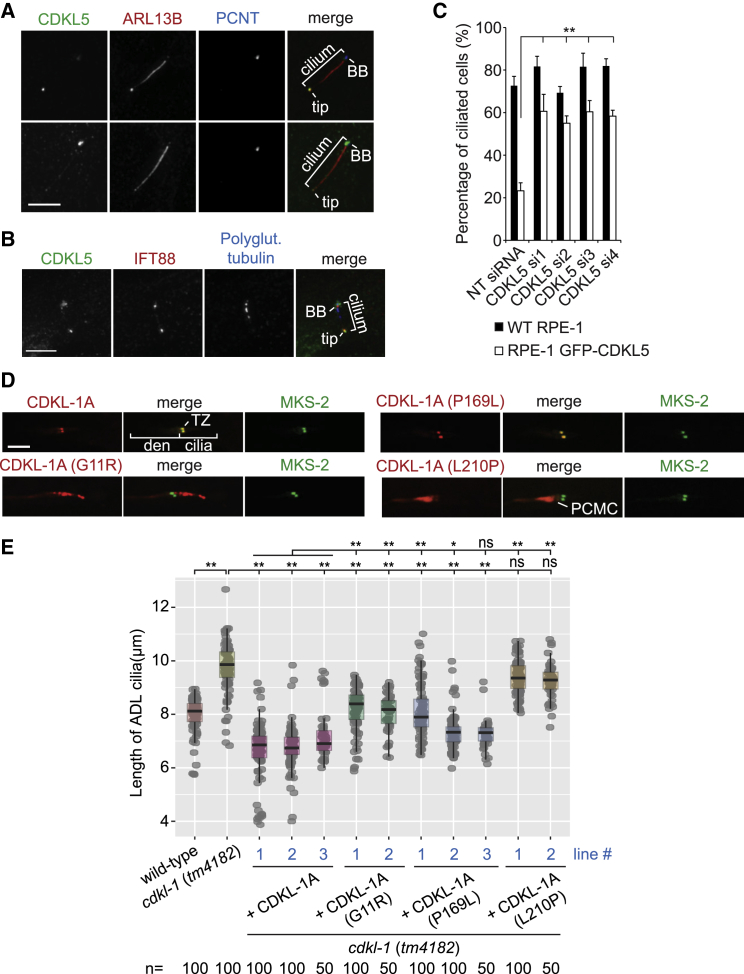
Human CDKL5 Localizes to Cilium and Affects Ciliogenesis When Overexpressed in RPE-1 Cells and Mutations Modeled in C. elegans CDKL-1 Disrupt Localization and/or Cilium Length Regulation(A) Immunofluorescence analysis of serum-starved hTERT RPE-1 cells expressing GFP-CDKL5 stained with antibodies against GFP, ARL13B (cilium marker), and PCNT (centrosome marker). The top and bottom panels are representative images showing different levels of GFP-CDKL5 localization to the BB and cilium tip. Scale bar, 5 μm.(B) Serum-starved hTERT RPE-1 GFP-CDKL5 cells were stained with antibodies against GFP, IFT88, and polyglutamylated tubulin (centriole/BB and axoneme marker). Scale bar, 5 μm.(C) Bar graph shows mean percentage of ciliated cells (n > 300 cells per sample, 3 independent experiments) in the serum-starved populations (72 hr) of hTERT RPE-1 and hTERT RPE-1 GFP-CDKL5 cells transfected with the indicated siRNAs. Error bars indicate SD. ∗∗p < 0.01 (Student’s two-tailed t test).(D) WT CDKL-1A and the P169L variants localize to the TZ, whereas the G11R mutant localizes along the length of cilia, and the L210P mutant accumulates in dendrites (den) and is weakly present at the periciliary membrane compartment (PCMC). MKS-2 is a TZ marker. Scale bar, 4 μm.(E) ADL cilia lengths (L4 larvae) of WT and strains expressing CDKL-1 variants. Expressing WT CDKL-1A leads to short cilia. Similar levels of length reduction are not seen upon expression of the G11R and L210P variants, or lines 1 and 2 of the P169L variant (line 3 is not significant), suggesting functional defects with these variants. Dot is one cilium. Significance (p value) was calculated by Dunn Kruskal-Wallis multiple comparison (Holm-Sidak adjustment). ∗p < 0.01 and ∗∗p < 0.001; ns, not significant.